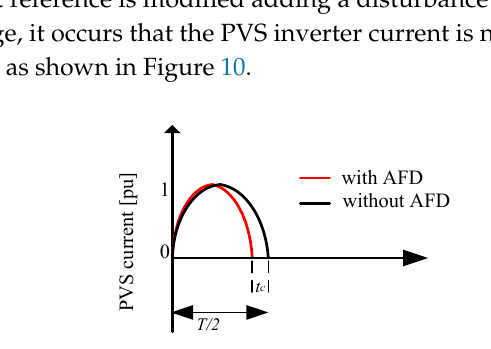
Figure 10. Half wave of the PVS inverter current with and without active frequency drift (AFD). During grid-connected operation the PVS inverter voltage is not affected by the perturbation. Di ff erently in islanding operation the PVS inverter voltage “drifts” up or down as a consequence of the continuous inverter current variation. The frequency change has to be detected by the UOF protections. Successively the PVS is promptly